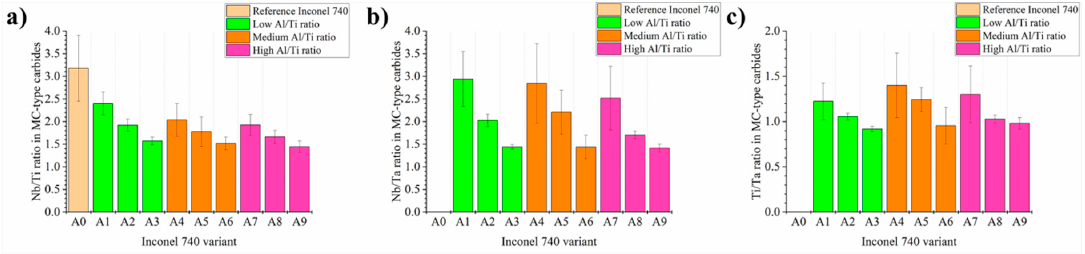
Figure 12. Concentration relationships between selected elements in the MC carbides: ( a ) Nb / Ti; ( b ) Nb / Ta; ( c ) Ti / Ta, based on SEM-EDX results in at%.